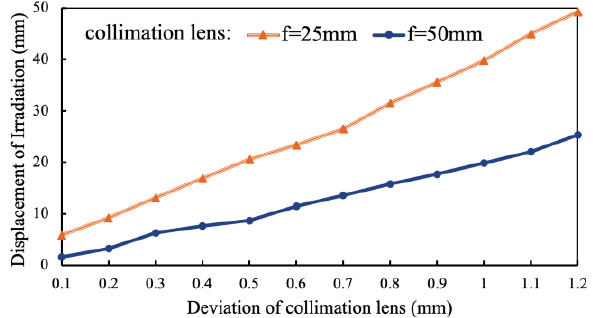
Figure 10. Displacement of irradiation place caused by lens